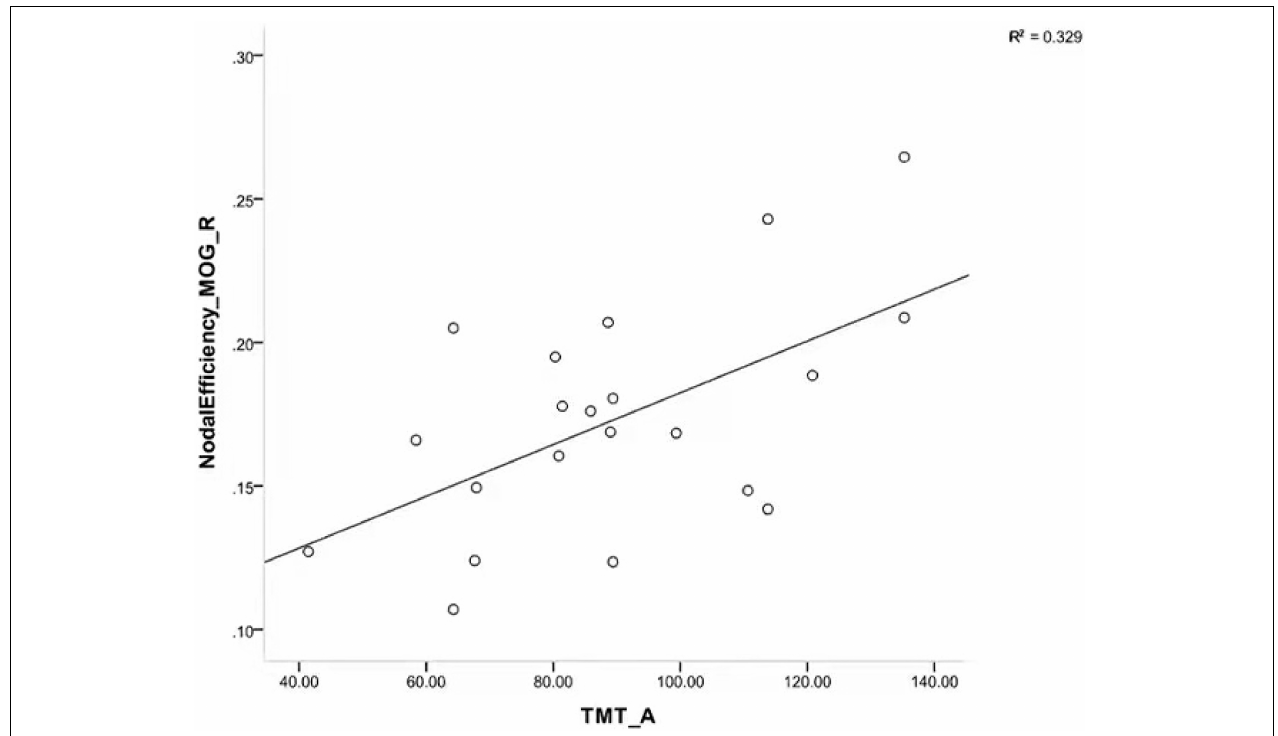
FIGURE 3 | Scatterplot showing a significant positive correlation between TMT-A scores and node efficiency of right MOG in patients with iRBD. TMT-A, trail making test part A; MOG, middle occipital gyrus; iRBD, isolated rapid eye movement sleep behavior